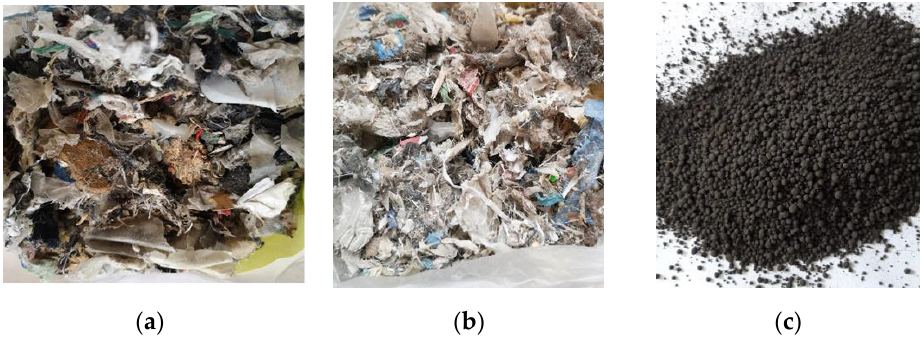
Figure 2. The tested waste sample: ( a ) refuse-derived fuels–RDF 1, ( b ) refuse-derived fuels–RDF 2, and ( c ) sewage sludge–SS. Table 1. The heat distribution in the two-components blends, (in %). No.